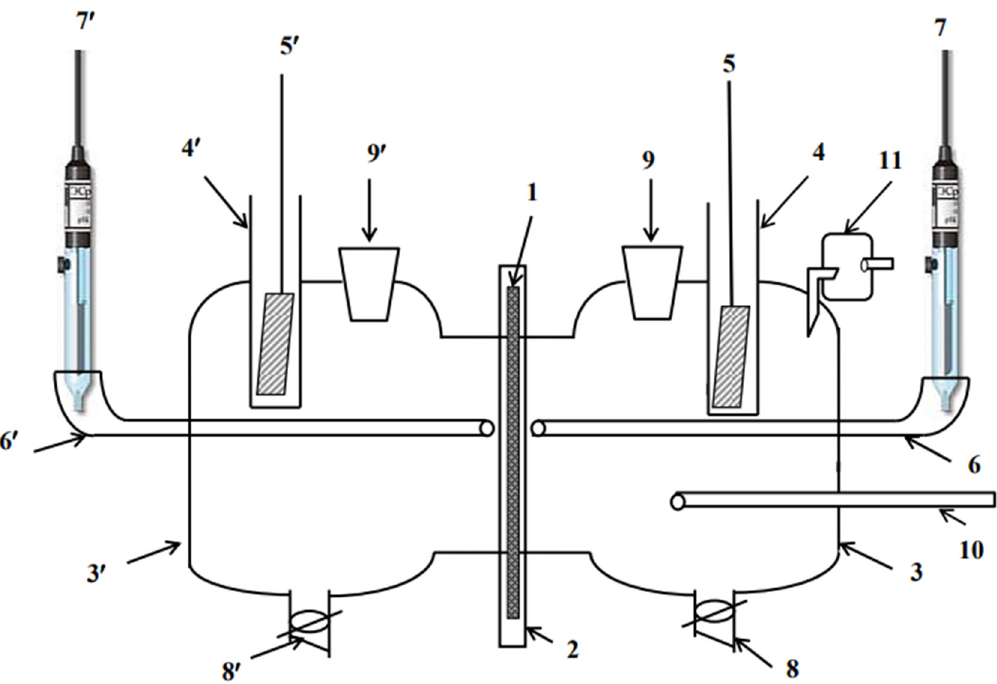
Figure 1. Devanatkhan-Stakhursky electrochemical cell: 1—working electrode (membrane); 2—Teflon holder; 3—working part of the cell; 3 ′ —diffusion part of the cell; 4, 4 ′ —auxiliary electrode cell; 5, 5 ′ —auxiliary electrode; 6, 6’—electrolytic switch; 7,7 ′ —reference electrode; 8, 8’—tap for draining the solution; 9, 9 ′ —solution input into the cell; 10—argon input into the cell; 11—water seal.